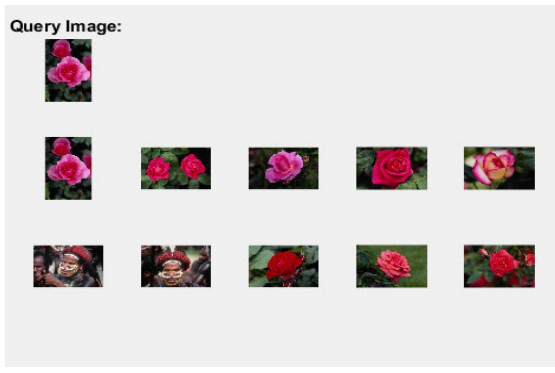
Figure 8. Retrieved top 10 images by proposed method from GHIM-10K dataset